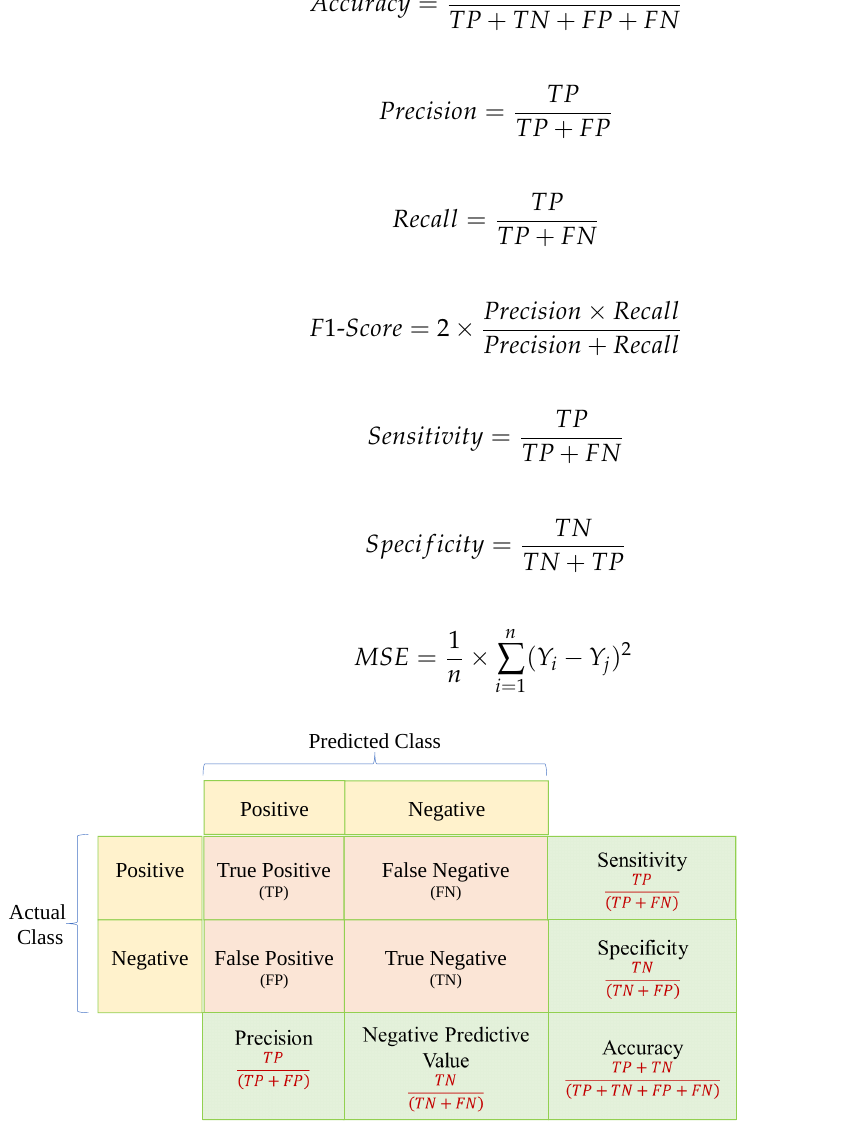
Figure 7. Confusion